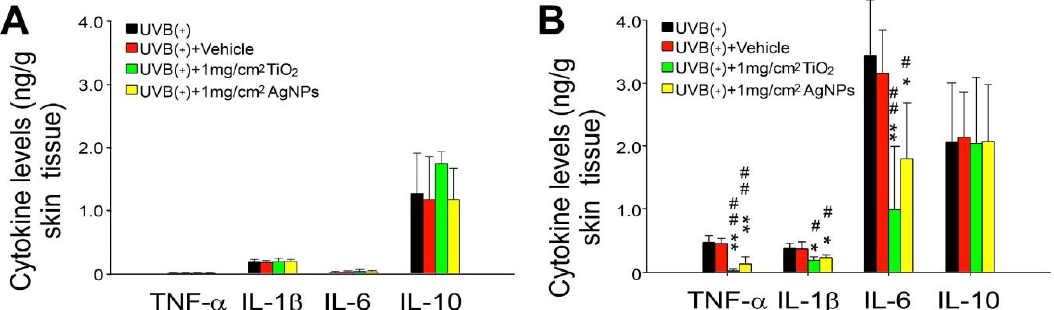
Figure 5. AgNPs rescue UVB-induced skin expression of proinflammatory cytokines in mice. Enzyme-linked immunosorbent assay was performed to examine the expression of proinflammatory cytokines TNF–α, IL–1β, and IL–6 and anti-inflammatory cytokine IL–10 in mouse skin without ( A )